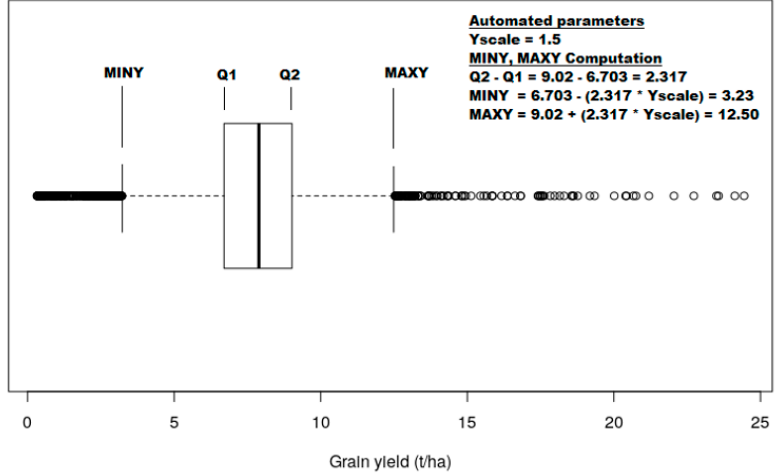
Figure 5. 2017 harvest yield boxplot and method for computing automated MIN-Y and MAX-Y filter parameter values.